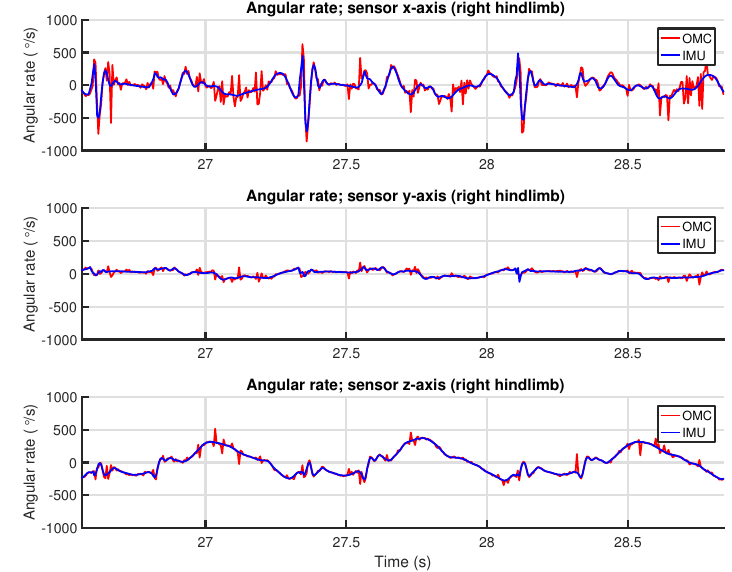
Figure 13. Example of the alignment of angular velocity between IMU and